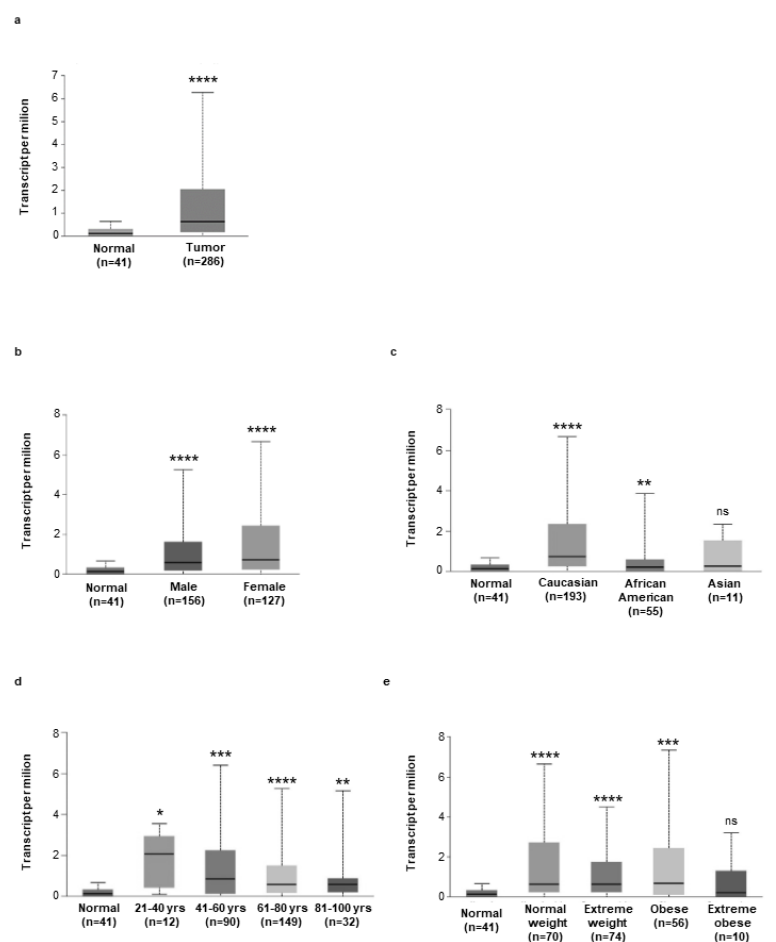
Figure 2. ( a ). Expression of hepcidin in colorectal cancer samples ( n = 256) and normal tissue samples ( n = 41), as evaluated by using the UALCAN database (cancer vs. normal (**** p < 0.0001). ( b – e ). Expression of hepcidin RNA in different groups of CRC based on patients’ gender ( b ) [Normal ( n = 41) versus CRC male ( n = 156), **** p < 0.0001; Normal ( n = 41) versus CRC female ( n = 127), **** p < 0.0001], patients’ ethnicity ( c ) [Normal ( n = 41) versus CRC Caucasian ( n = 193), **** p < 0.0001; Normal ( n = 41) versus CRC African American ( n = 55), ** p < 0.01; Normal ( n = 41) versus CRC Asian ( n = 10), ns]; patients’ age ( d ), [Normal ( n = 41) versus CRC 21–40 years ( n = 12), * p < 0.05; Normal ( n = 41) versus CRC 41–60 years ( n = 90), *** p < 0.001; Normal ( n = 41) versus CRC 61–80 years ( n = 149), **** p < 0.0001; Normal ( n = 41) versus CRC 81–100 years ( n = 32), ** p < 0.01], patients’ weight [Normal ( n = 41) versus CRC normal weight ( n = 70), **** p < 0.0001; Normal ( n = 41) versus CRC extreme weight ( n = 74), **** p < 0.0001; Normal ( n = 41) versus CRC obese ( n = 56), *** p < 0.001; Normal ( n = 41) versus CRC extreme obese ( n = 10), ns] was examined by using the UALCAN